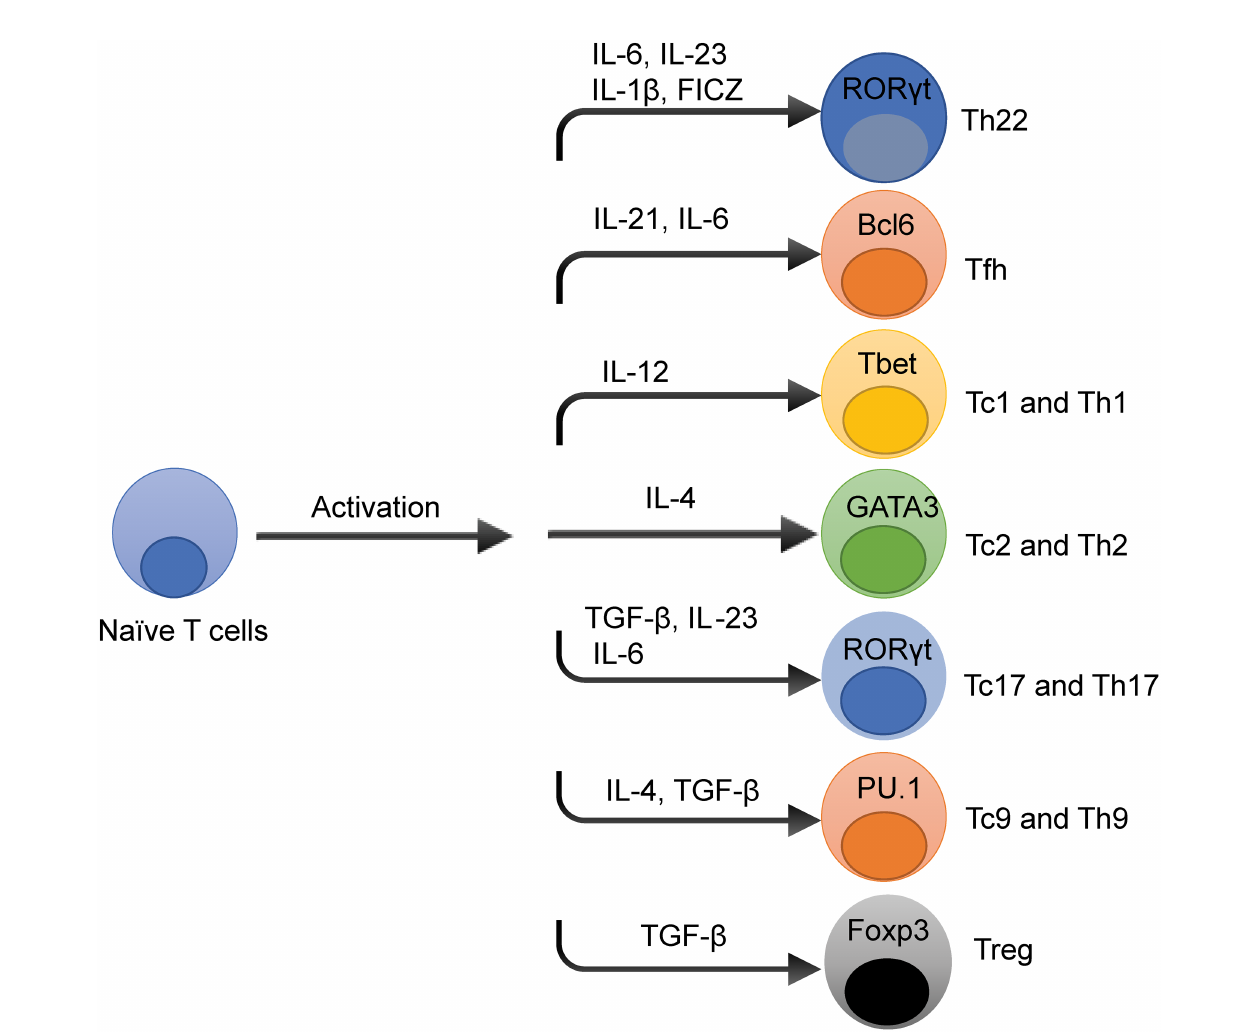
FIGURE 1 | Overview of T Cells Differentiation Pathways. The cytokine and transcription factors (TFs) niche dictates T cell differentiation in spite of the stimulation of T cell receptor signaling pathways. The prototypical cytokines and TFs that regulate each T cell subset differentiation fate are depicted. These cytokines and TFs that in fl uence T cell differentiation have effects on the development of multiple T cell subsets, such as interleukin-6 (IL-6) is essential for T helper type 22 (Th22), T follicular helper (Tfh), and T helper 17 (Th17) cell